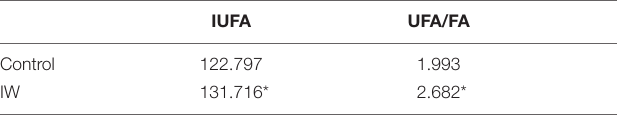
TABLE 2 | Effect of intermittent warming on index of unsaturated fatty acid of blueberry fruit at the day 4 of shelf life at room temperature after 30 days refrigeration.